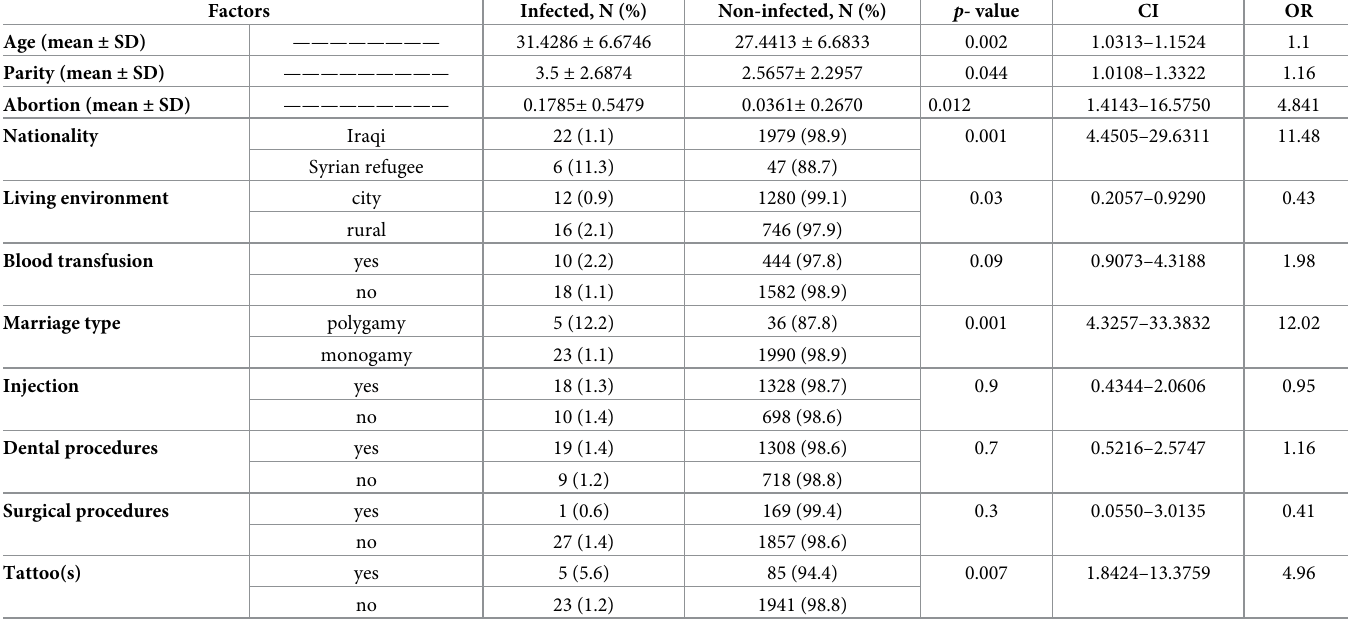
Table 2. Risk factors for HBsAg positivity among pregnant